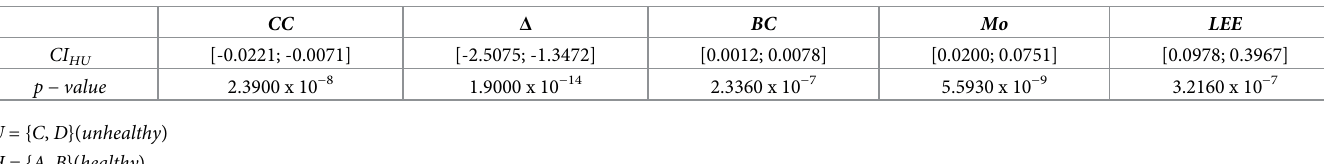
Table 1. Statistical comparison (95% confidence interval, p < 0.05) among the sample means of the network measures CC, Δ , BC, Mo, and LEE for the groups A, B, C and, D, through ANOVA.